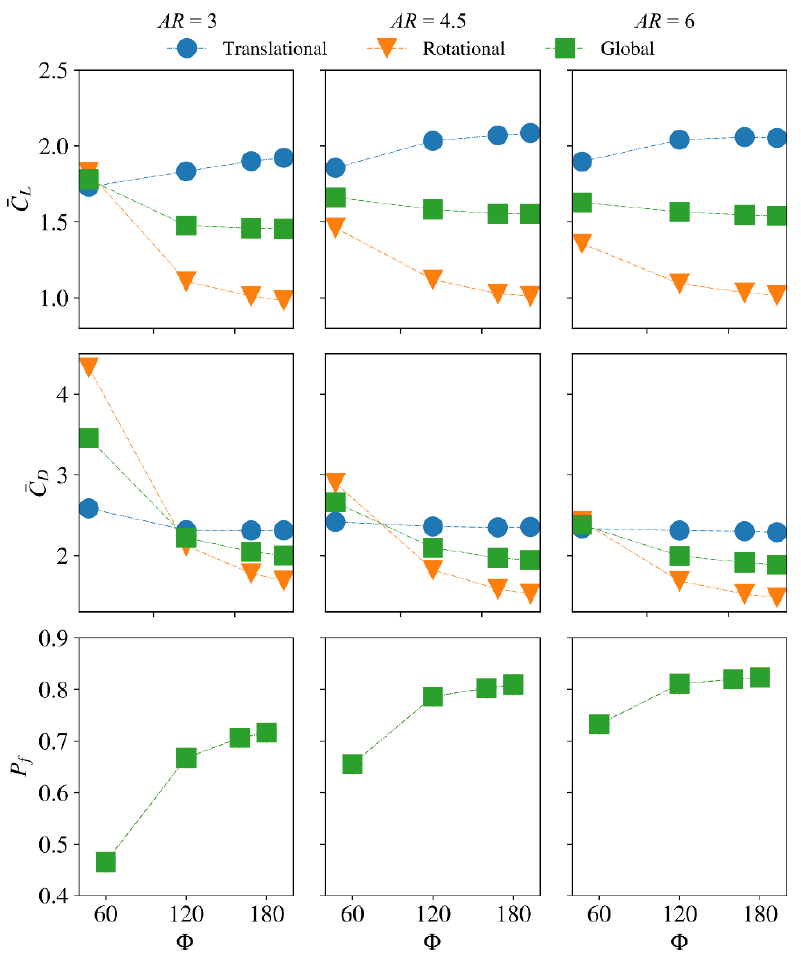
Figure 8. Comparison of the average lift and drag coefficients as well as power factor for different stroke amplitudes and aspect ratios. The dimensionless radial centroid location is fixed to 0.5.